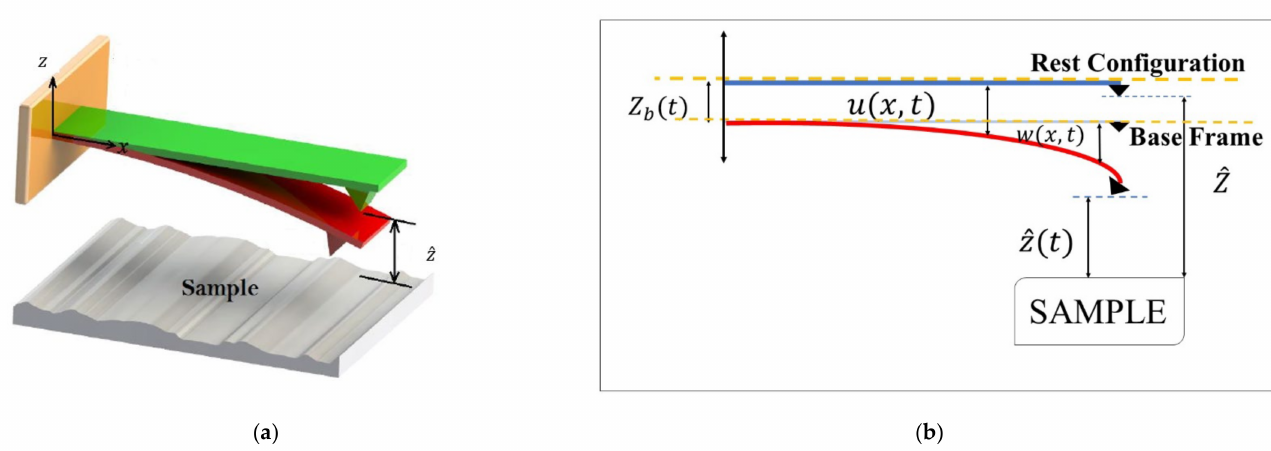
Figure 1. The schematic view of an AFM’s cantilever scanning a sample. ( a ) 3D view of the AFM. ( b ) 2D view of the